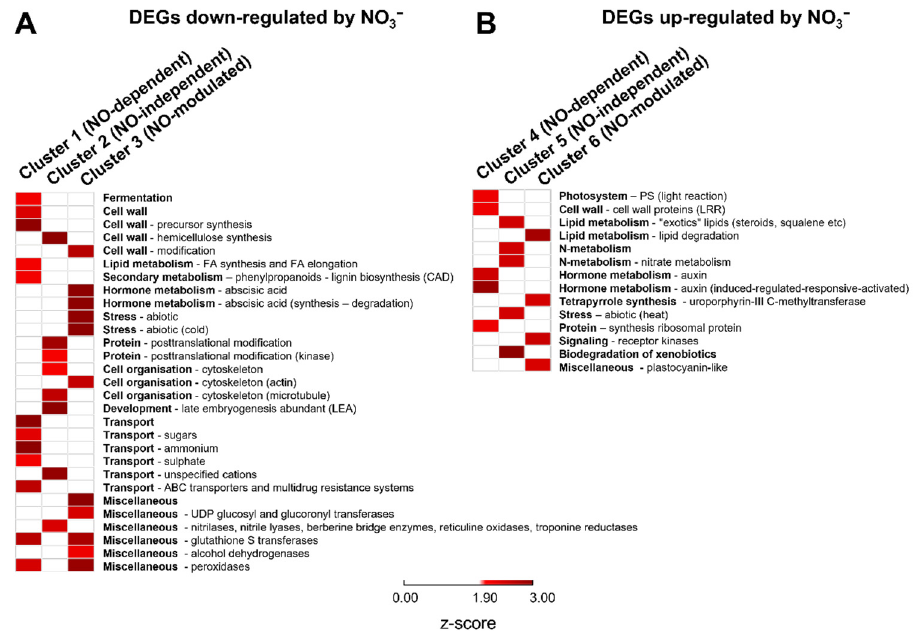
Figure 3. MapMan functional categories enrichment of DEGs identified in the six groups (( A ) down-regulated by nitrate provision; ( B ) up-regulated by nitrate provision) using the PageMan tool with Fisher’s test. PageMan automatically converted the p -values to their corresponding z-scores (e.g., 1.96 for a p -value of 0.05). In the map, white boxes represent no enrichment, while different magnitudes of red show increasing significance of the enriched terms.